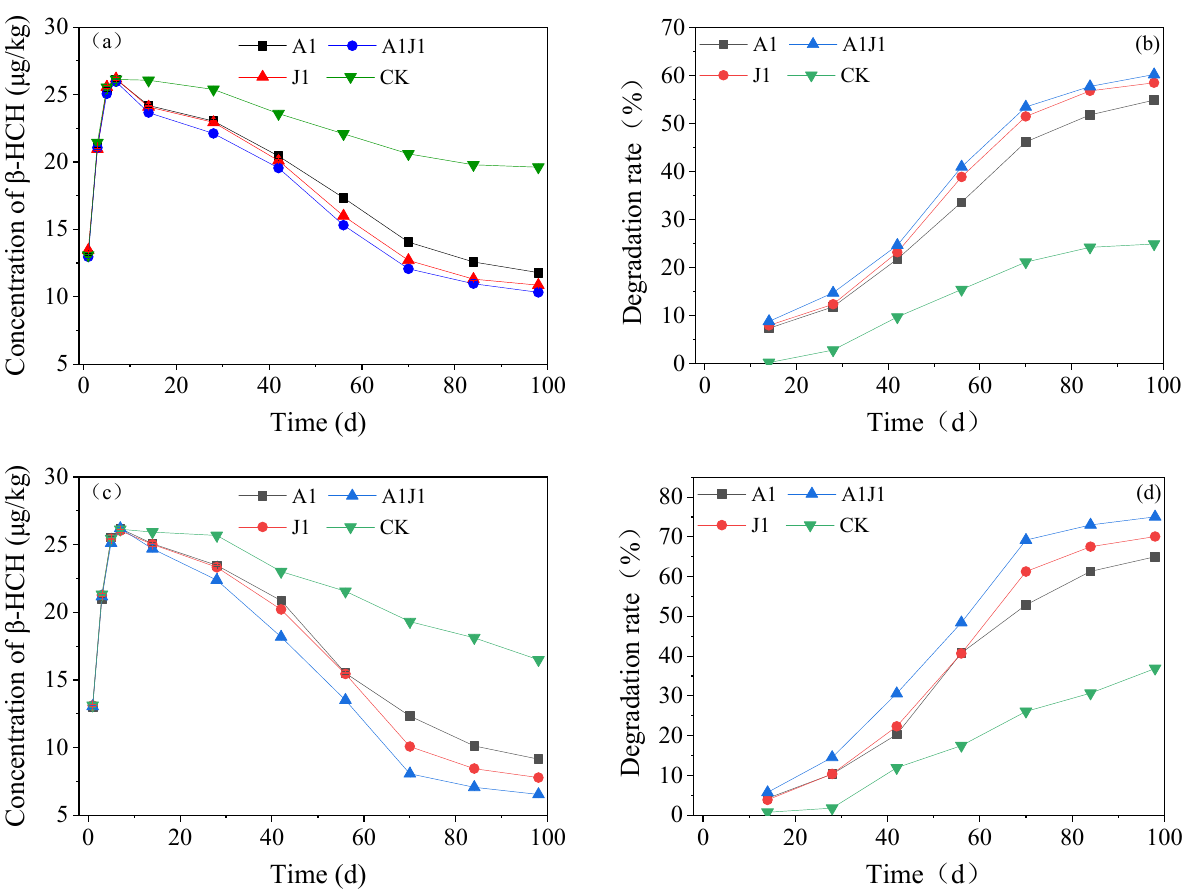
Figure 5. Plots of β -HCH content ( a ) and degradation rate ( b ) in soil with conventional treatment and β -HCH content ( c ) and degradation rate ( d ) in soil after addition of root secretions over time. It was noted that group K, without any treatment, could also degrade nearly one-fourth of the β -HCH, which indicated that some primitive microorganisms in the soil already had the ability to degrade β -HCH and could adapt to its toxic effects. Soil-indigenous microorganisms can adjust and adapt to the disturbed environment and have the potential to progressively metabolize foreign contaminants [39]. In addition, the experimental conditions were conducted at a constant temperature of 30 ◦ C, which attenuated the effect of ambient temperature on soil microorganisms. The effect of temperature on soil microorganisms is crucial, and a suitable temperature can greatly enhance the metabolic capacity of soil microorganisms, thus promoting the decomposition and transformation of pollutants [40]. Figure 5c shows the changes in β -HCH content in the soil with time. The changes in the β -HCH degradation rate with time when different strains of bacteria were treated with the addition of root exudates is shown in Figure 5d. The content of β -HCH in the soil of each group decreased more rapidly after 14 d, after the addition of root exudates, and there was a significant reduction in the final content. The addition of root exudates increased the degradation rate of β -HCH significantly in the soil under different treatments, and the degradation rate of β -HCH in the groups A_R, J_R, AJ_R and K_R finally increased by 10.14%, 11.56%, 14.81%, and 11.96%, respectively, compared with the experimental group without the addition of root exudates, with the most significant increase in group AJ. Therefore, it can be inferred that the injected strains A1 and J1 and the compound bacterial agent AJ may not have antagonistic effects with soil-indigenous microorganisms, and the coupling with root exudates was more obvious and had the potential for engineering